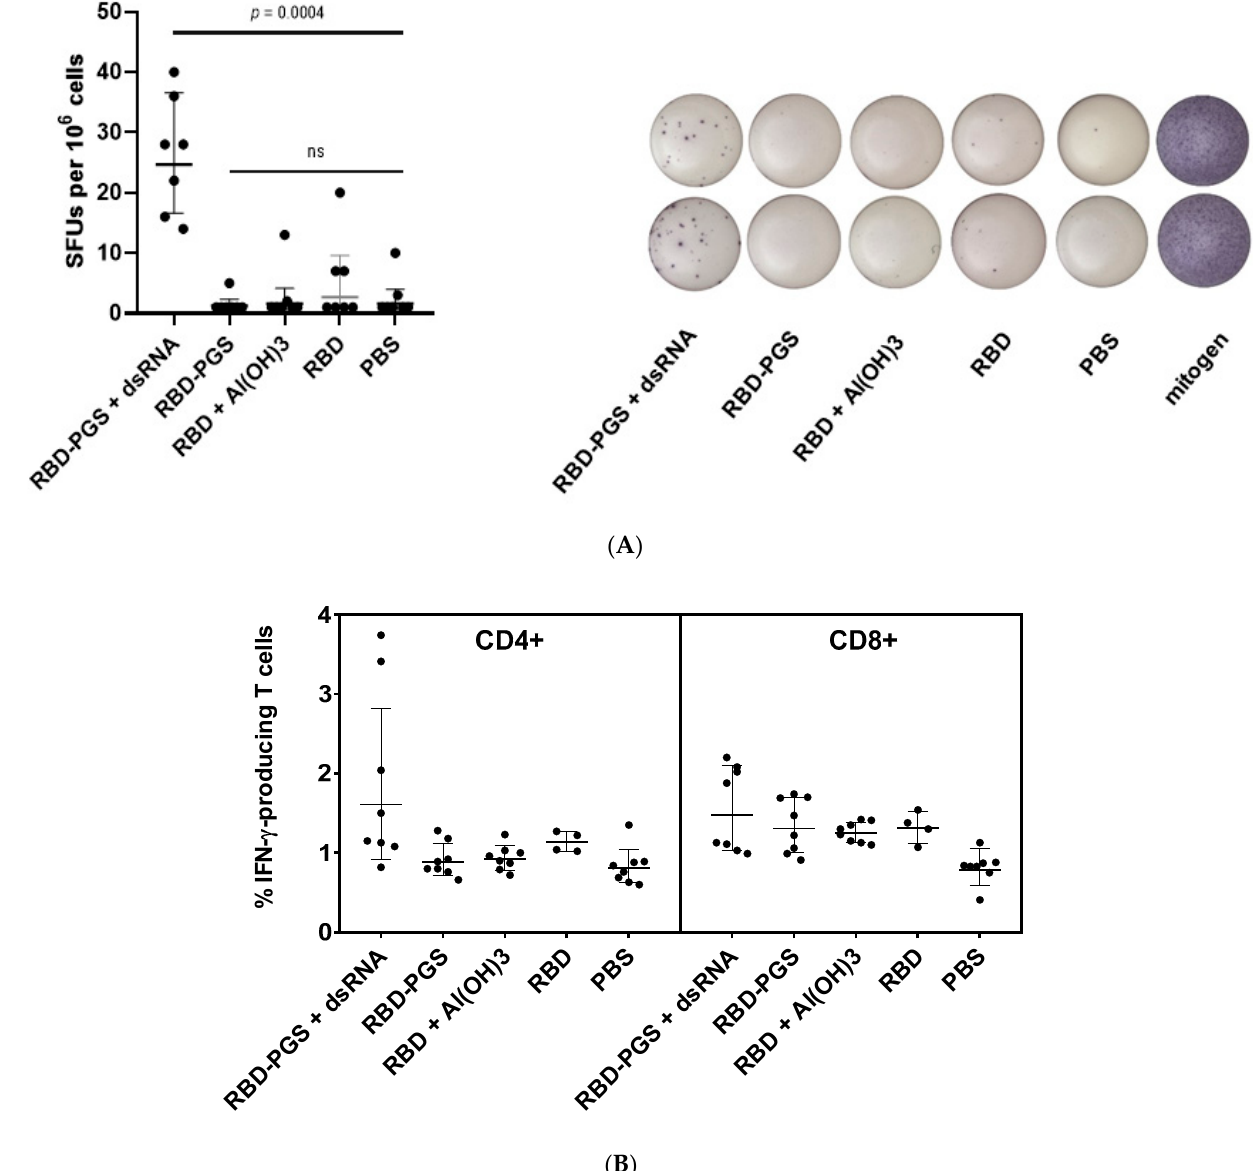
Figure 3. T-cell immune response to conjugated RBD in BALB/c mice: ( A ) ELISpot and ( B ) ICS analyses of mouse splenocytes. The geometric mean ± SD is presented. Statistical analyses were performed using the Mann–Whitney U test and Kruskal–Wallis H tests. p -values indicate statistical